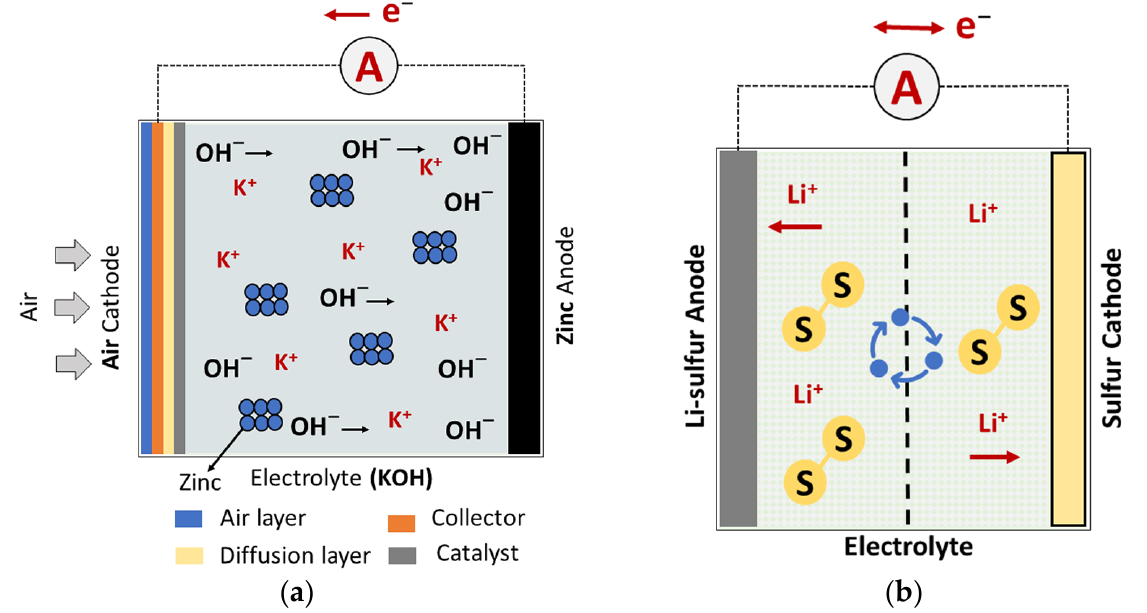
Figure 9. Composition of battery cell (future generation). ( a ) Zn-air cell. ( b ) Li-S cell.